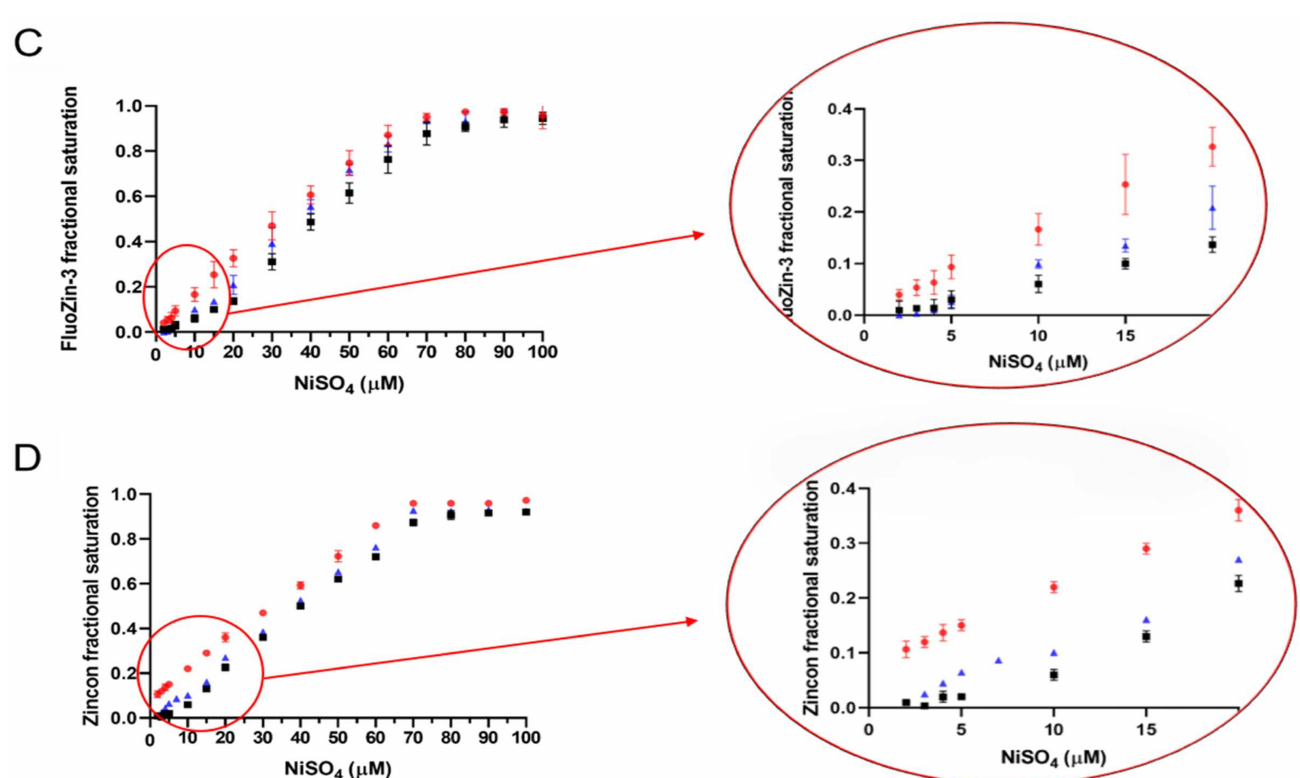
Figure 4. Nickel affinity of the two ZnT8 C-terminal domain (CTD) variants before and after alkylation. ZnT8cW. Nickel binding in competition with FluoZin-3 ( A ) and Zincon ( B ). Measuring fluorescence at 515 nm and absorbance at 653 nm, 70 µ M NiSO 4 saturates 70 µ M FluoZin-3/Zincon in 50 mM HEPES (4-(2-hydroxymethyl)-1-piperazineethanesulfonic acid), 300 mM NaCl, 100 mM sucrose, pH 8 in agreement with the stoichiometry of the complex (red circles). In competition with 5 µ M ZnT8cW, no signals at 515 nm or 653 nm are detected until 10 µ M NiSO 4 is added, revealing two high-affinity nickel binding sites in ZnT8cW which outcompete FluoZin-3/Zincon (black squares). When ZnT8cW is incubated with iodoacetamide for 1 h prior to the FluoZin-3/Zincon competition assay, only 5 µ M NiSO 4 is required to elicit the initial signals at 515 and 653 nm and the stoichiometry decreases to 1 (blue triangles). ZnT8cR. Nickel binding in competition with FluoZin-3 ( C ) and Zincon ( D ). NiSO 4 titration of FluoZin-3/Zincon alone in HEPES buffer (red circles), in competition with ZnT8cR (black squares), and in competition with ZnT8cR modified with iodoacetamide (blue triangles), demonstrates that ZnT8cR also contains two high affinity nickel binding sites and that one binding site is blocked by